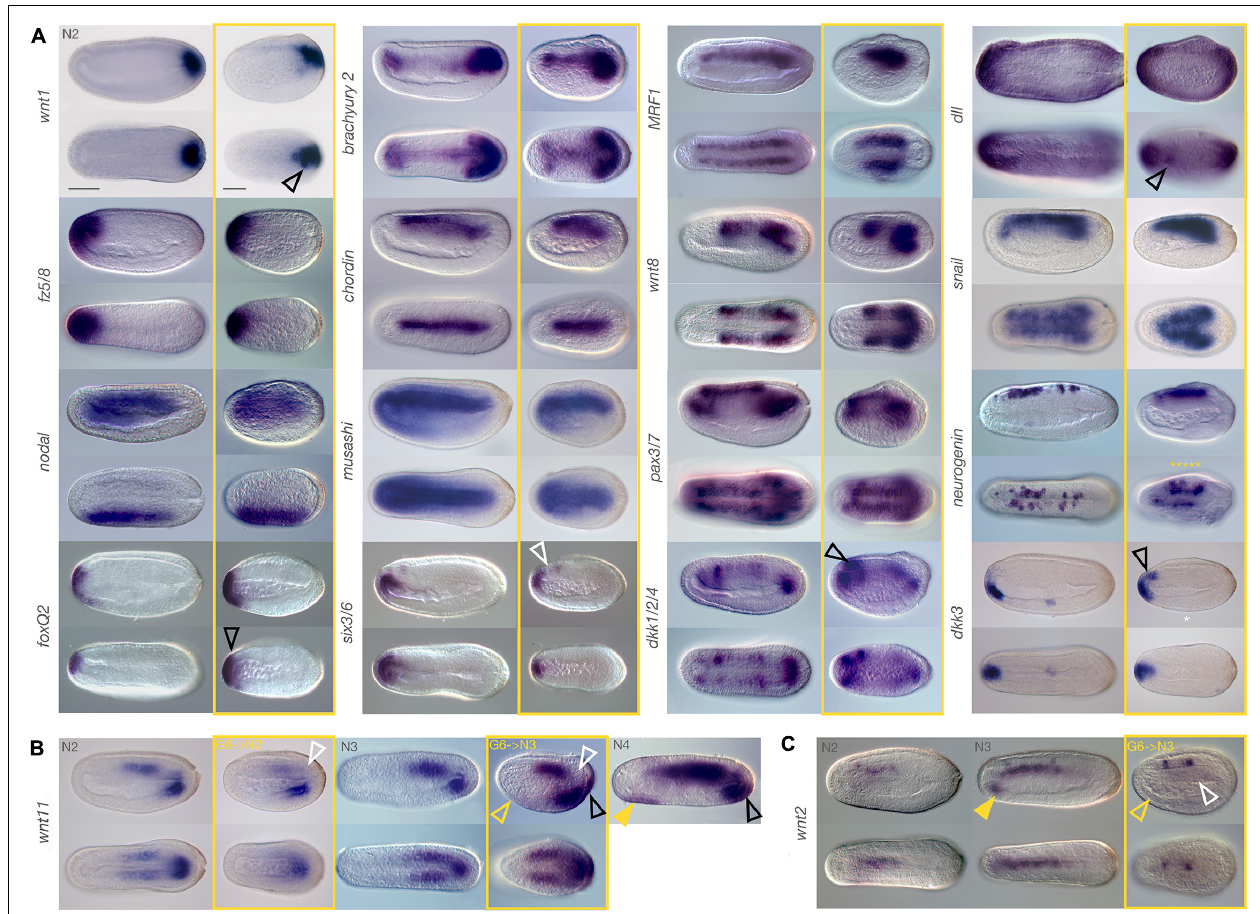
FIGURE 2 | Marker gene expression after JNK inhibition at late gastrula stages is modulated. Embryos were treated with 10 µ M SP600125 and allowed to develop to N2, N3, or N4 stages (boxed in yellow). Stage matched controls are on the left. (A) Treated embryos generally show similar expression patterns to the controls. Exceptions include dkk1/2/4 , dkk3 , dll , foxQ2 , and wnt1 which show slightly expanded or ectopic expression (black outlined arrowheads), and six3/6 , which appears to lack expression in the anterior notochord (white outlined arrowhead) despite comparable neural expression. Irregular expression of neurogenin in neurons along either side of the midline (yellow asterisks) is also apparent. (B) After treatment with the JNK inhibitor, wnt11 expression is reduced relative to control N2 embryos (white arrowhead). By N3, chordoneural hinge expression is still absent (white outlined arrowhead), and there is no ventral endoderm expression (yellow outlined arrowhead) similarly to controls. However, ectopic expression within posterior ectoderm of the tailfin is observed (black outlined arrowhead). This is more similar to N4 embryos (black outlined arrowhead) than to the stage matched N3 controls, but does not fit with anterior ventral endoderm expression in these later stage embryos (filled yellow arrowhead). (C) Expression of wnt2 is also dysregulated by JNK inhibition in the notochord (white outlined arrowhead) and in anterior ventral endoderm (yellow outlined arrowhead), relative to stage matched N3 controls, which also have expression in the notochord (compare to N2 embros). This occurs in spite of normal neural expression, and cannot be explained by a systemic delay of development. Representative embryos are shown. Scale bars = 50 µ